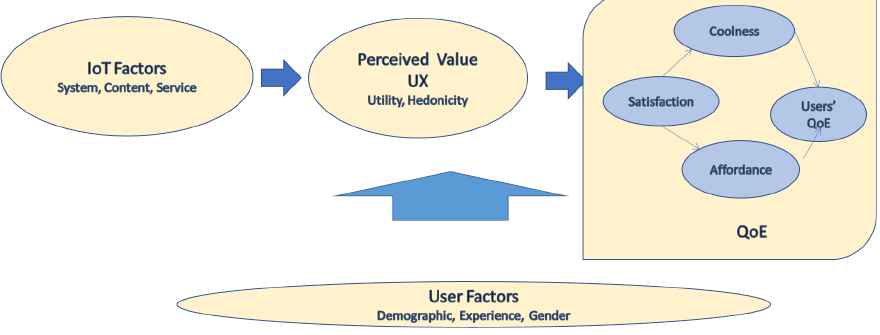
Figure 6. QoE IFs in the IoT context